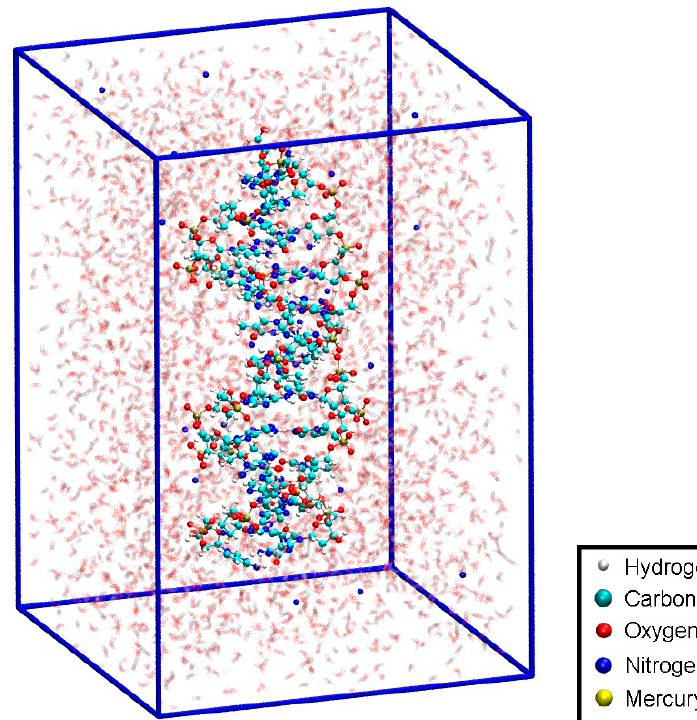
Figure 8. Initial structure 1 within the simulation box, with Na + ions displayed in blue and water molecules shown transparent.